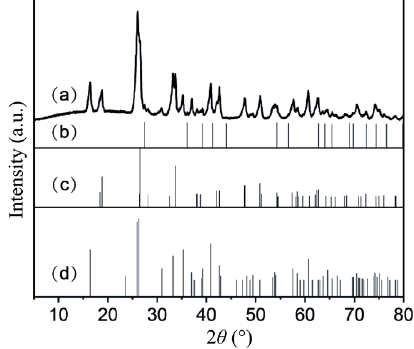
Fig. 6 XRD patterns of (a) 20 wt% TiO 2 doped mullite hollow fiber membranes at 1520 ℃ , and its related standards: (b) rutile TiO 2 standard, (c) Al 2 TiO 5 standard, (d) mullite